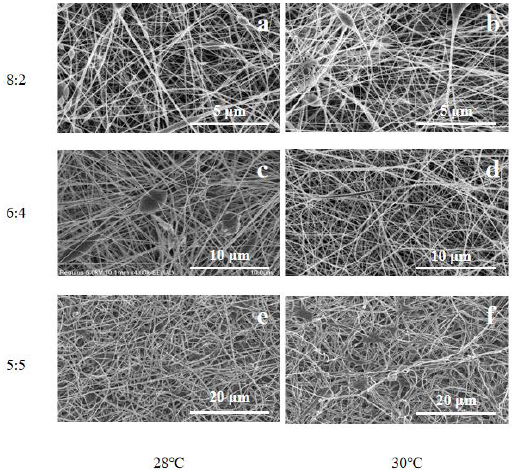
Figure 1. SEM images of fiber membrane at eletrospinning temperature of 28 °C with the DMF